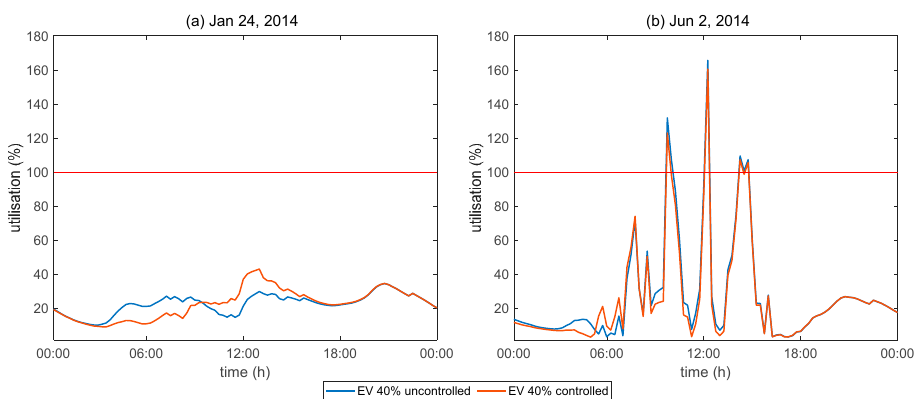
Figure 15. Comparison of the utilisation of the line 1 for a penetration of 40% EV and 60% PV with 3.7 kW charging power and charging strategy 1 and 2 for ( a ) 24 January ( b ) 2 June.